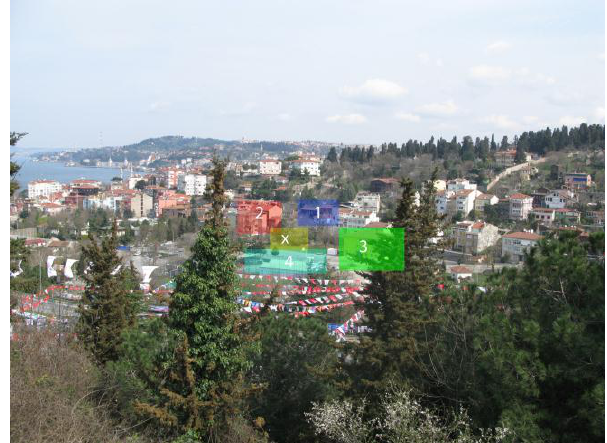
Figure 7. The location of the actual buildings